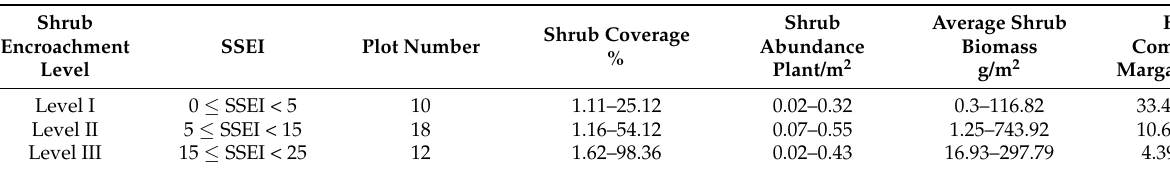
Table 1. The classification of shrubland plots.